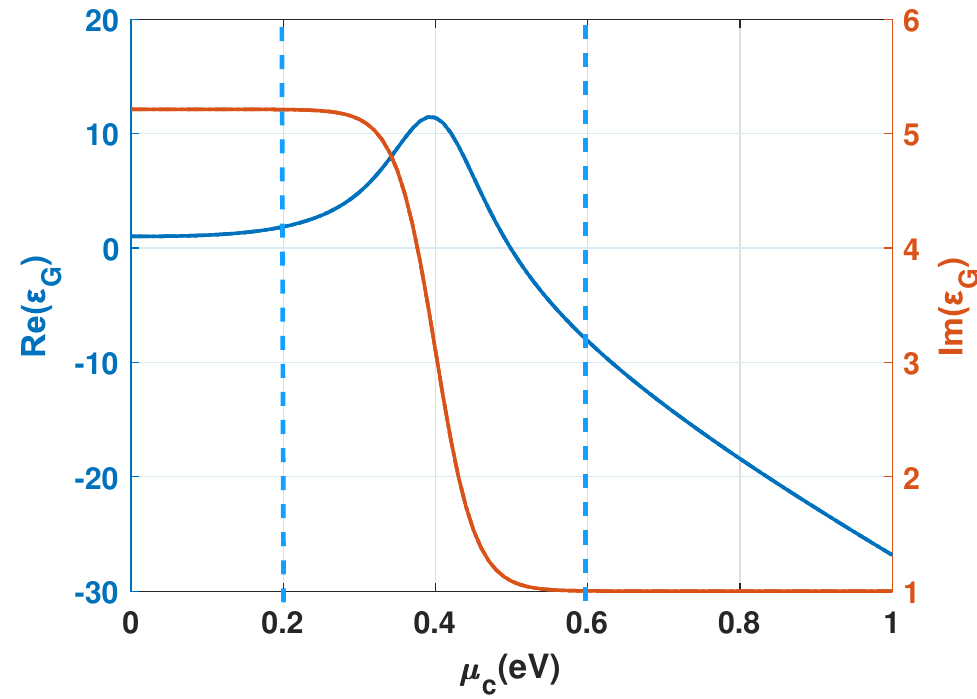
Figure 2. Graphene permittivity (real and imaginary parts) versus the chemical potential ( µ c ). The graph shows a high absorption region where graphene behaves as a lossy dielectric medium ( µ c < 0.2 eV), a transient region (0.2 eV < µ c < 0.6 eV) with a relatively low range of absorption, and a region of low absorption ( µ c > 0.6 eV) with a linear dependence where graphene behaves as a quasi-metallic